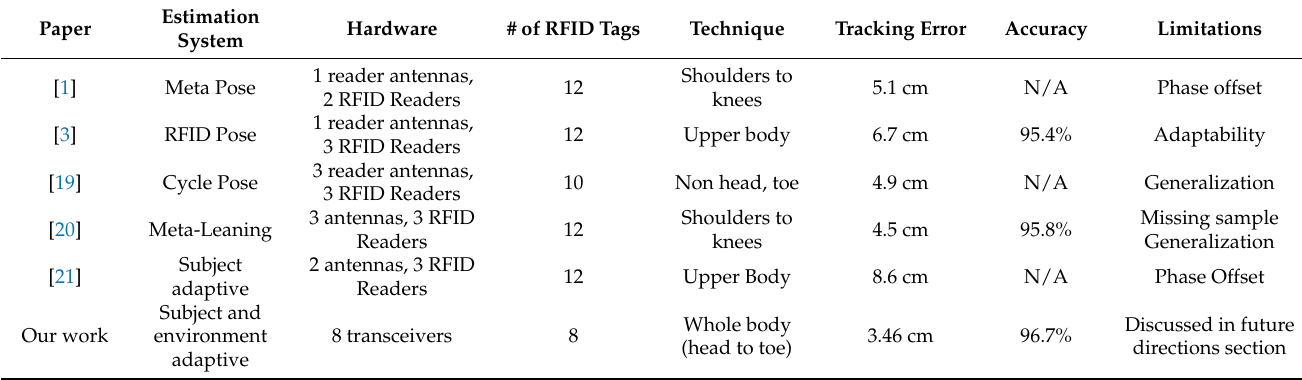
Table 1. Comparison of various related